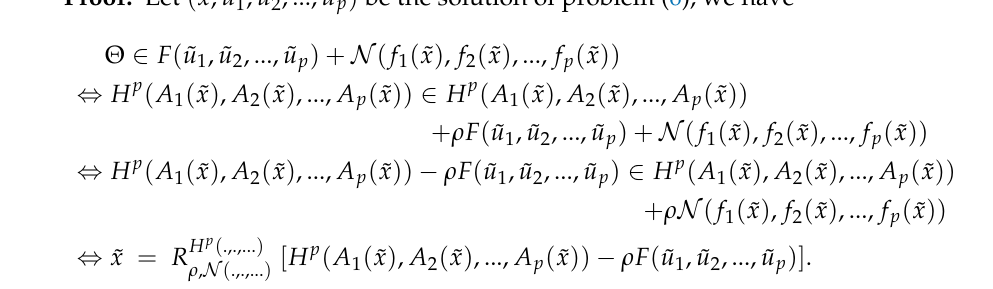
Algorithm 1. For any given x 1